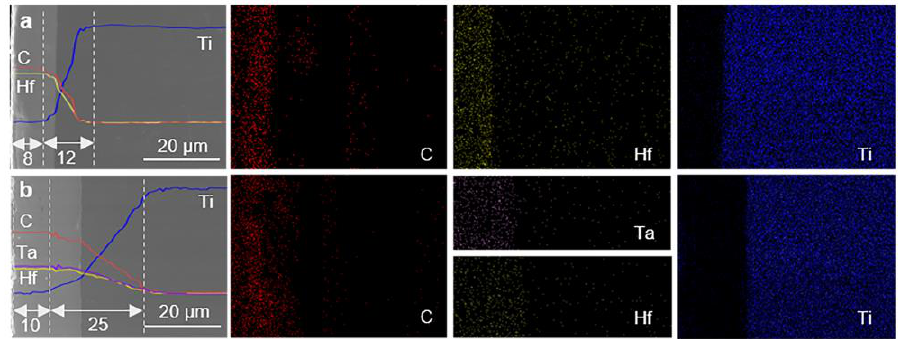
Figure 5. Section morphology and composition of ( a ) HfC coatings and ( b ) HfTaC 2 coatings.